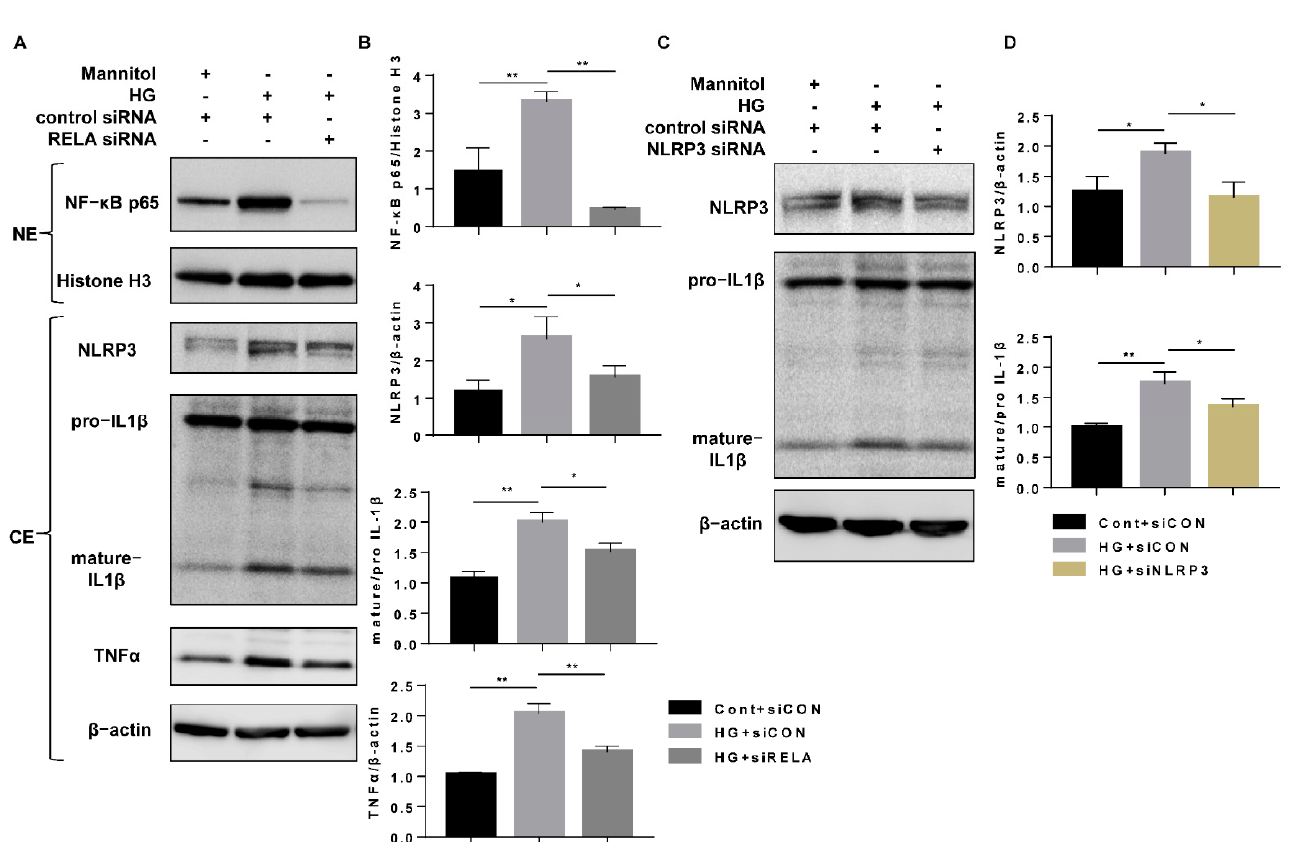
Figure 6. HG-induced inflammatory alteration via nuclear NF- κ B p65. ( A ) HK-2 cells were transfected with RELA siRNA (100 nM) or control siRNA for 6 h and then incubated in Cont or HG (30 mM) medium for 48 h. The levels of NF- κ B p65 in nucleoprotein extracts and NLRP3, IL-1 β , and TNF α in cytoplasmic protein extracts were assessed by western blotting. ( B ) Densitometric evaluation of ( A ) (n = 3). ( C ) HK-2 cells were transfected with NLRP3 siRNA (200 nM) or control siRNA for 6 h and then incubated with Cont or HG (30 mM) medium for 48 h. The levels of NLRP3 and IL-1 β were assessed by western blotting. ( D ) Densitometric evaluation of ( C ) (n = 3). All data represent means ± standard deviation (SD). * p < 0.05 vs. the indicated group, ** p < 0.01 vs. the indicated group. Cont, control; HG, high glucose; siCON, control siRNA; siRELA, RELA siRNA; siNLRP3, NLRP3 siRNA; NE, nucleoprotein extracts; and CE, cytoplasmic protein extracts.